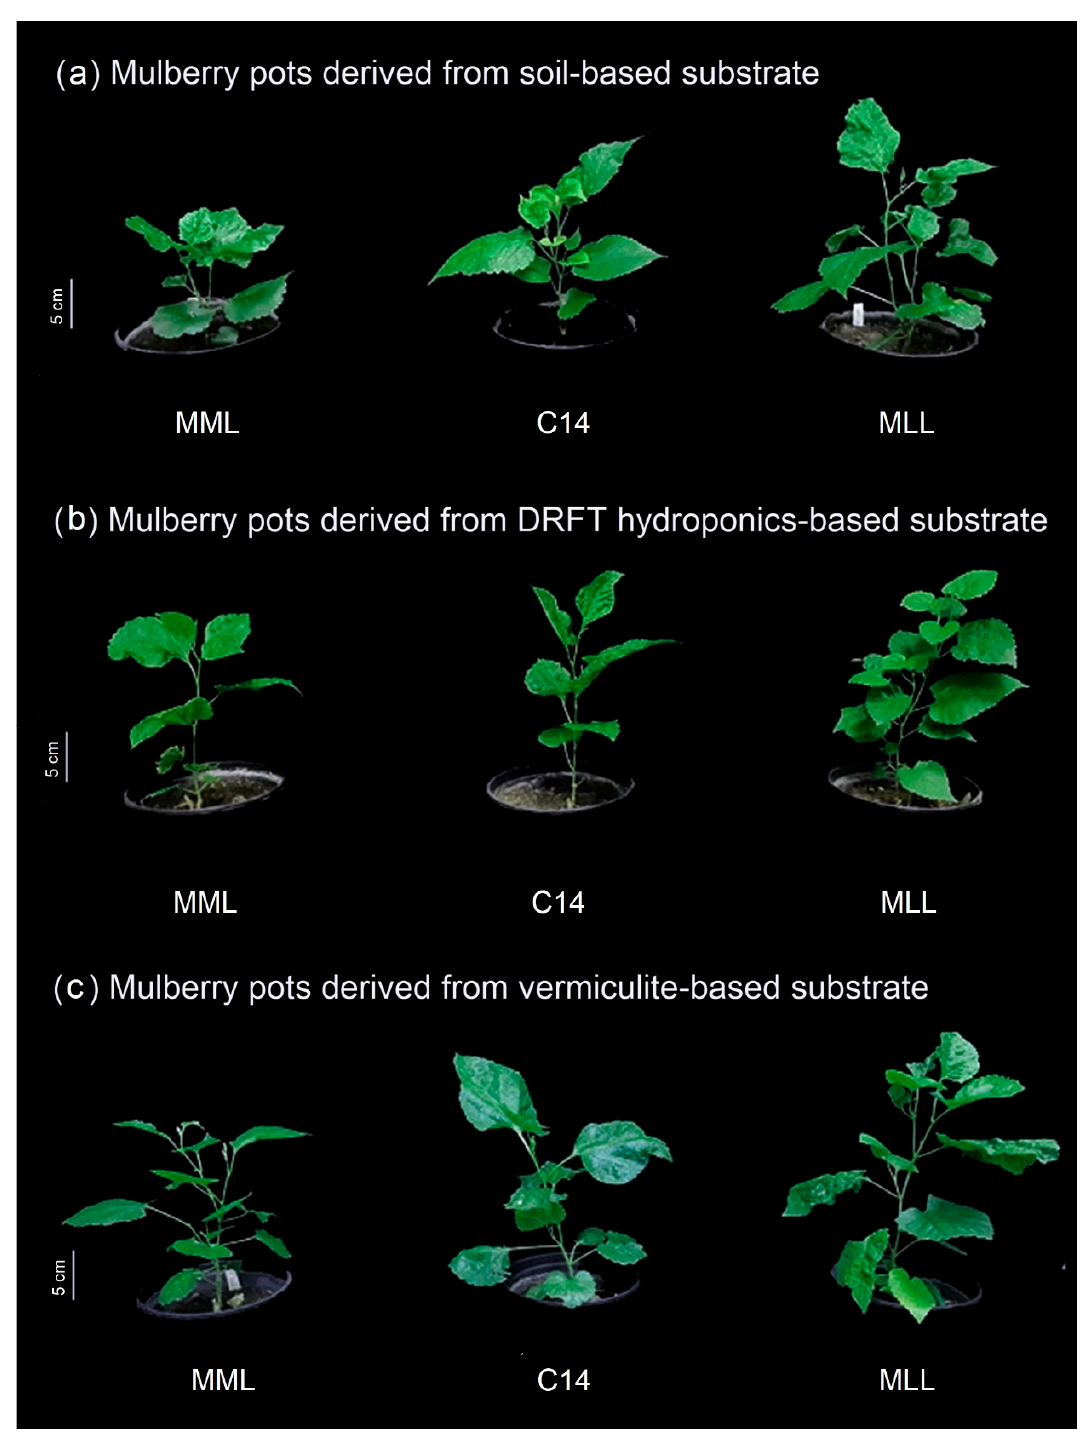
Figure 2. Morphological growth of mulberry cultivars: Myanmar medium leaf (MML), C14, and Myanmar large leaf (MLL) plants, grown in soil-containing pots after transfer from different pro- duction systems as soil ( a ), DRFT hydroponic ( b ), or vermiculite ( c ) from induction trays to pots for 60 days.